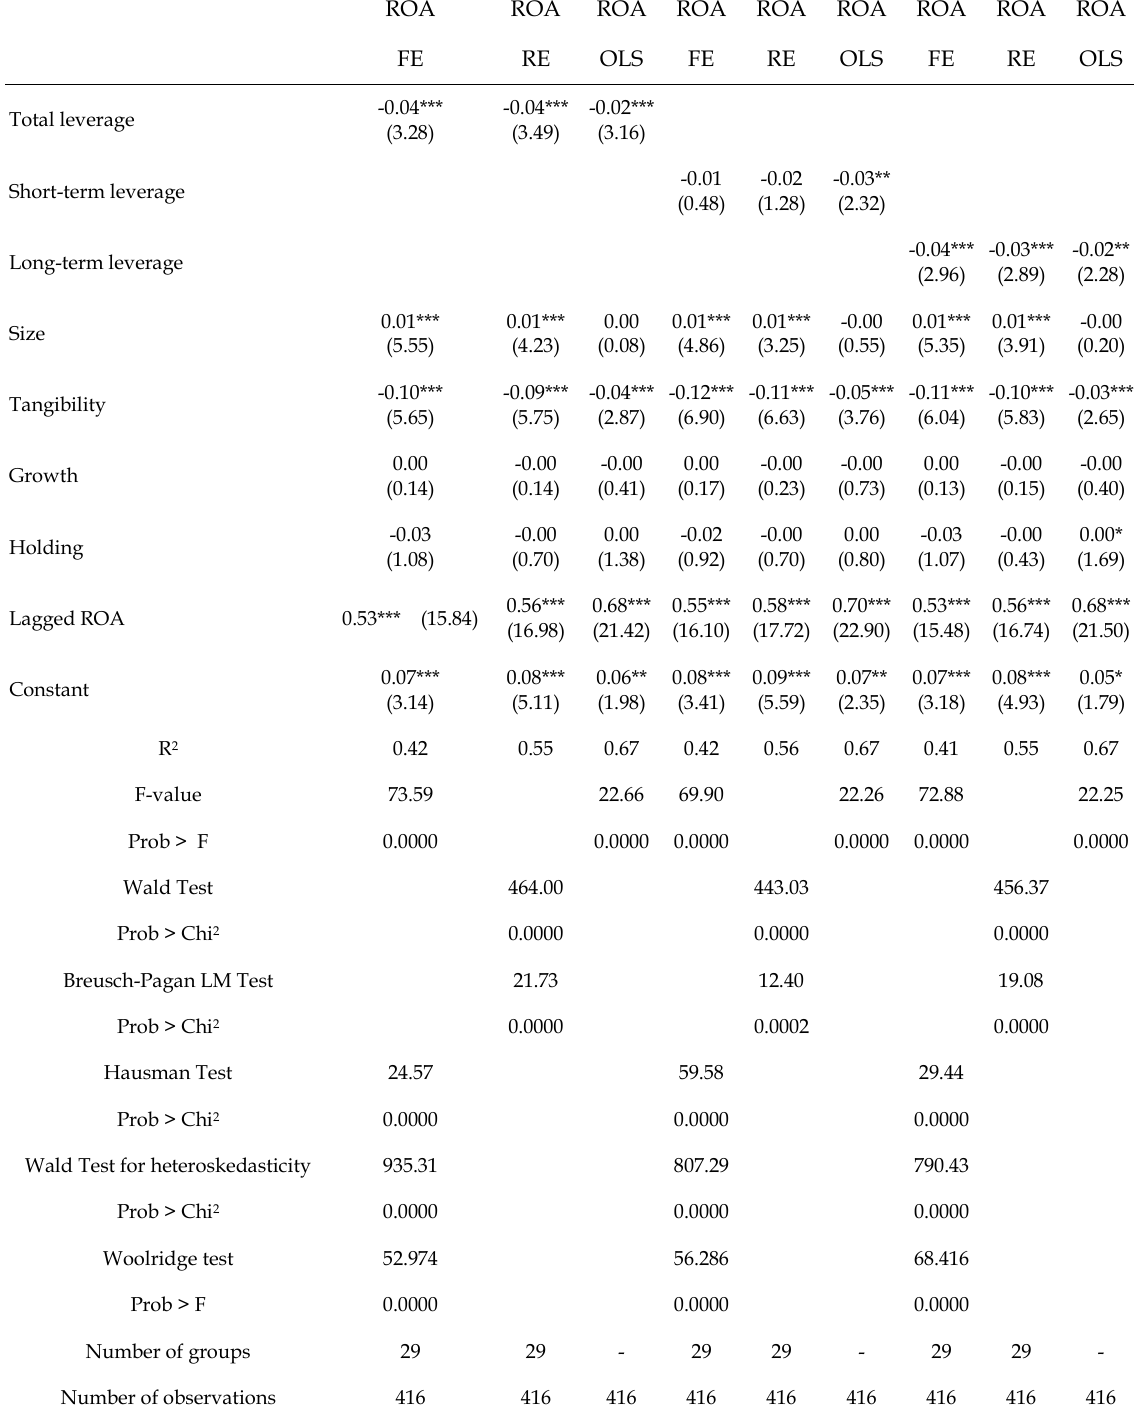
Table A2. Panel Data Estimation Results (Panel A) ROA ROA ROA ROA ROA ROA ROA ROA